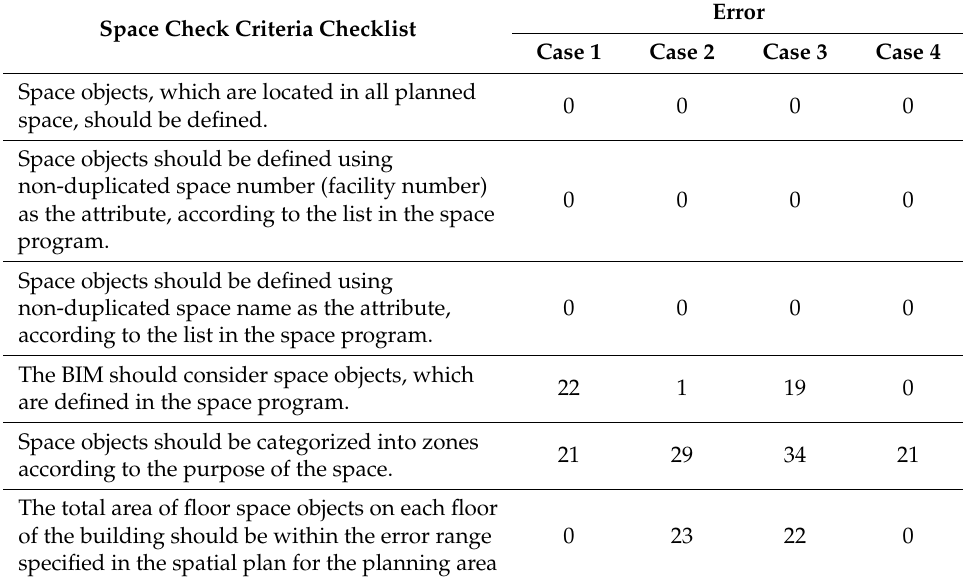
Table 9. The result of quality checking against space check criteria in case models.